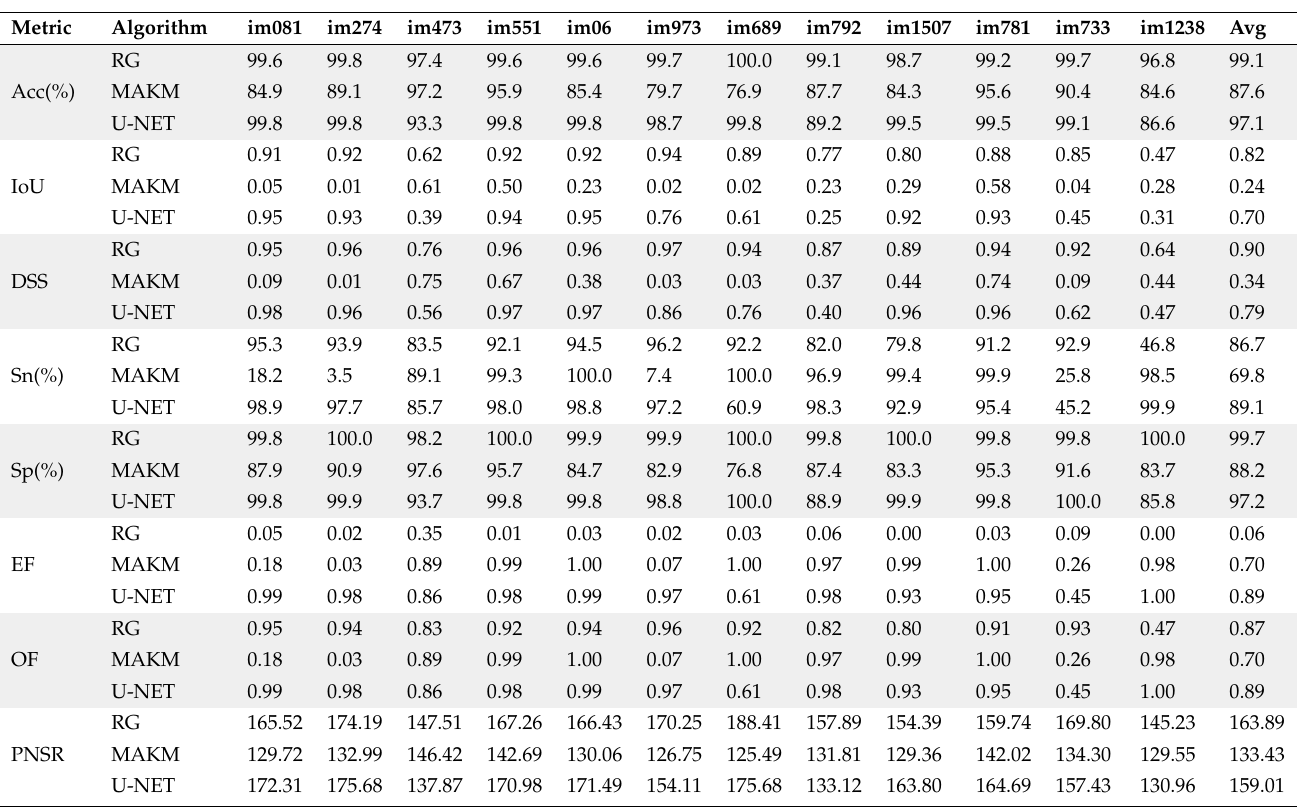
Table 2 indicates that the proposed algorithm outperformed modified adaptive K- means, and U-Net in terms of an average value of Acc, IoU, DSS, EF, and PSNR. However, it achieved a lower average value of Sn, Sp, and OF. The lower average value of Sn, Sp, and OF is achieved because of the least value of respective parameters for images 14 and 15. However, still, the U-Net and MAKM have an insignificant higher performance than the proposed approach. In the case of OF and Sn, U-Net achieved 4% and MAKM achieved 1% higher than the proposed approach. In the case of Sp, both the U-Net and MAKM are 1% higher than the proposed approach. Table 3 presented the comparison of the proposed approach, MAKAM and U-Net for the 12 randomly selected brain images from BRATS2015. The proposed approach scored a higher value of Acc, IoU, DSS, Sp, EF, and PSNR but a lower value of Sn and OF compared to MAKM and U-Net. The value of Acc, IoU, DSS, Sp, EF, and PSNR were 99.1%, 0.82, 0.90, 99.7%, 0.06, and 163.89 respectively whereas the value of Sn and OF were 89.1% and 0.89 respectively. U-Net achieved a higher value for both Sn and OF compared to MAKM and the proposed approach where performance difference was limited to nearly to 2%. Table 3. Performance comparison of RG with MAKM and U-Net for 12 randomly selected brain images from BRATS2015 Dataset.